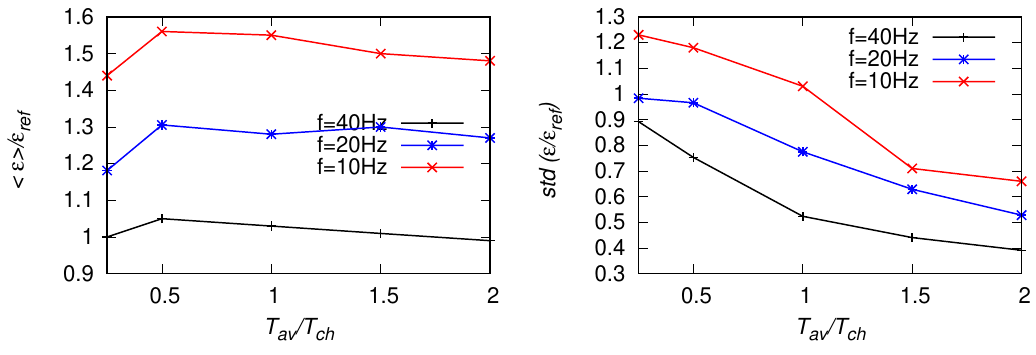
Figure 26. Statistics of (cid:101) VAR estimates based on the iterative method, Equation (10), for the fitting range f = [ 1 ÷ 5 ] Hz, from POST signals [15] with f s = 40 Hz, 20 Hz and 10 Hz. Left panel : EDR averaged along the signal, right panel : standard deviation of the estimates.